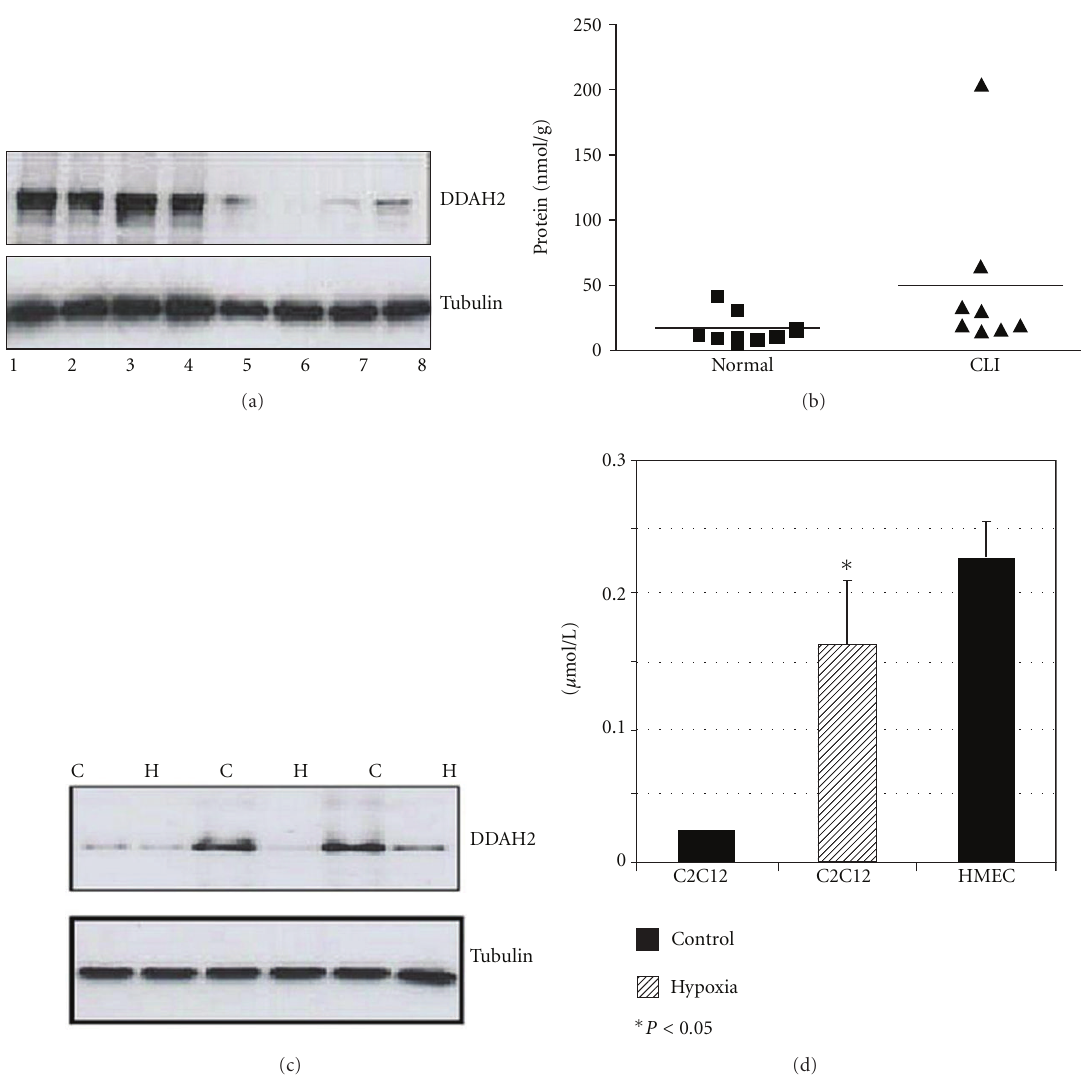
Figure 2: ADMA/DDAH pathway in ischaemic muscle—preliminary data. (a) Western blot showing reduced DDAH2 expression in muscle biopsies from patients with CLI. Lanes 1–4: control, 5–8: CLI muscle. (b) ELISA showing significantly higher ADMA levels in muscle from patients with CLI ( P = 0 . 03, Mann Whitney U test). (c) Western blot showing reduced DDAH2 expression in hypoxic myotubes (C: